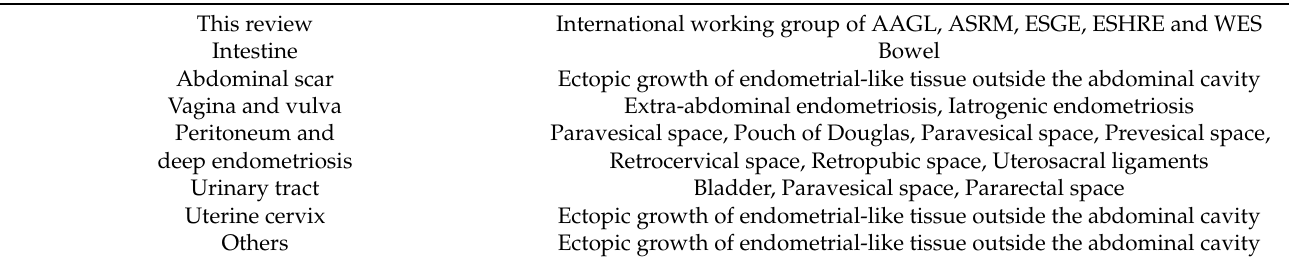
Ectopic growth of endometrial-like tissue outside the abdominal cavity AAGL, the American Association of Gynecologic Laparoscopists; ASRM, the American Society for Reproductive Medicine; ESGE, the European Society for Gynaecological Endoscopy; ESHRE, the European Society of Human Reproduction and Embryology; WES, and the World Endometriosis